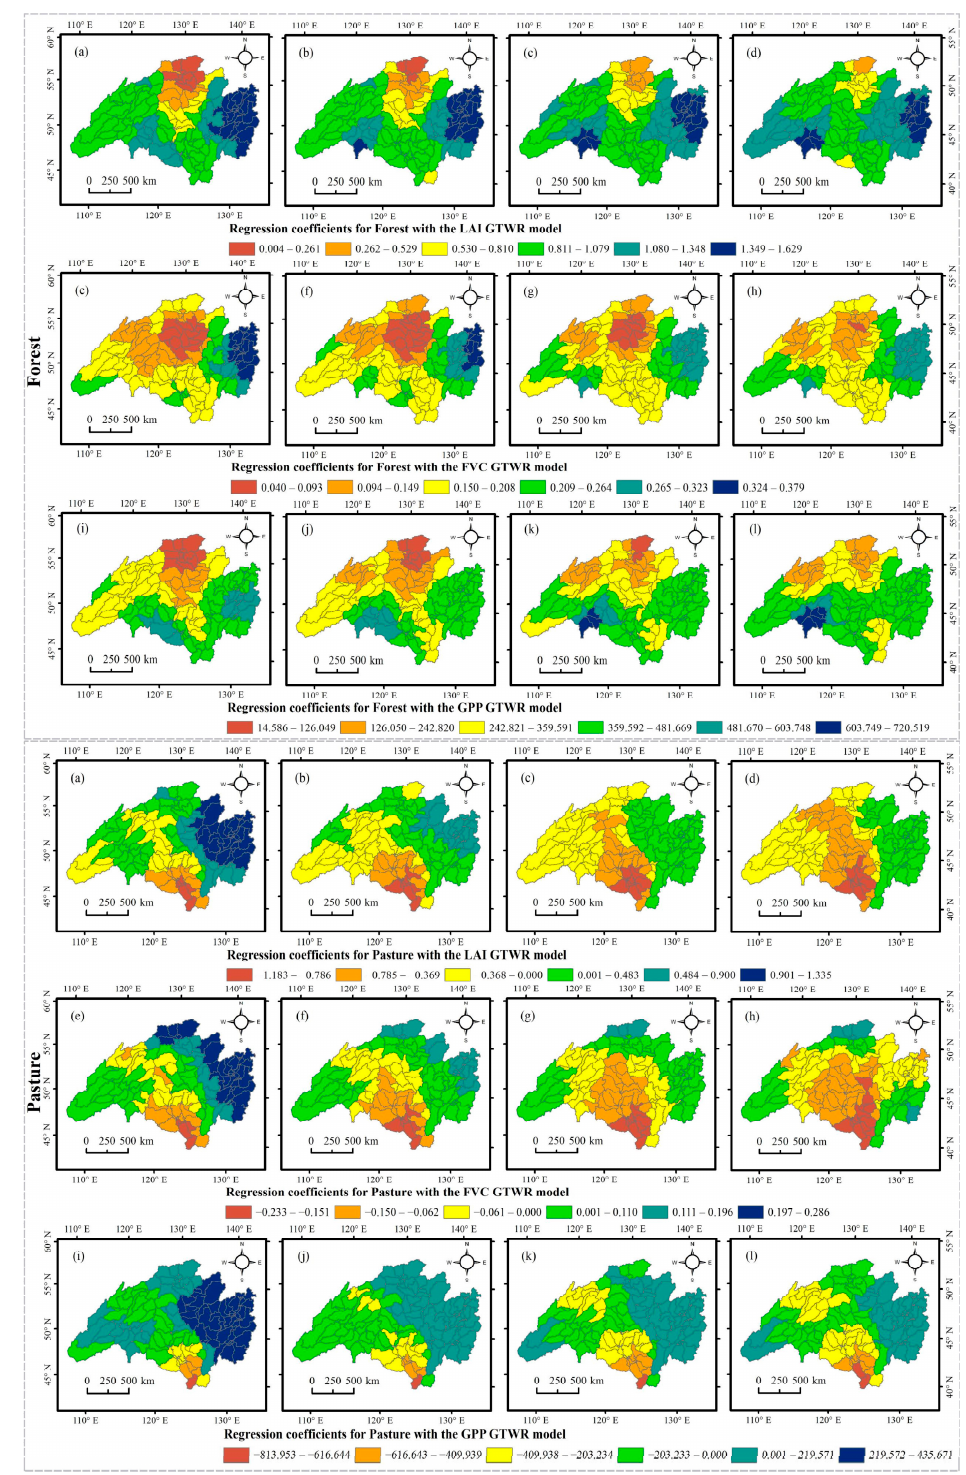
Figure 7. The spatial distribution of the regression coefficients for forest and pasture with LAI (( a – d ) display the coefficients for Periods 1–4, respectively), FVC (( e – h ) show the coefficients for Periods 1–4, respectively), and GPP (( i – l ) present the coefficients for Periods 1–4, respectively) GTWR models for the four studied periods.